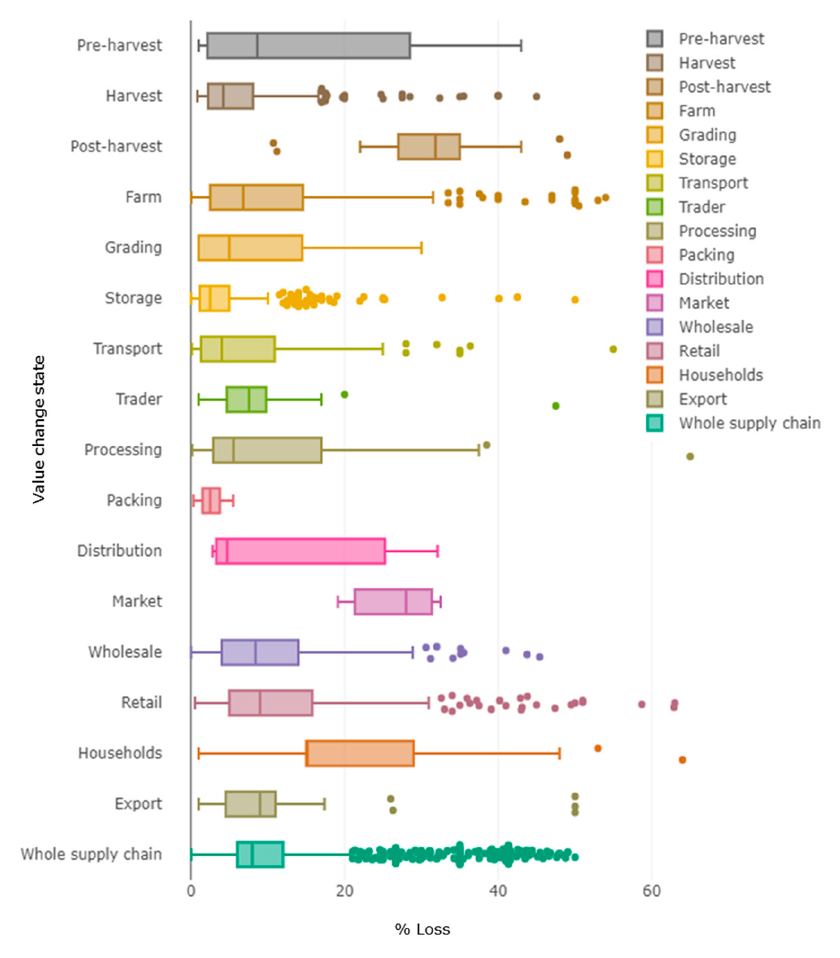
Figure 1. Food loss (%) of F&V in the world by Food Loss and Waste Database (FAO). Year range: 2000–2020; Aggregation: World; Basket items: Fruit and Vegetable; Country: All; Method data collection: all. Reprinted/adapted with permission from Ref. [2]. Copyright year: 2022; copyright owner’s name: FAO.